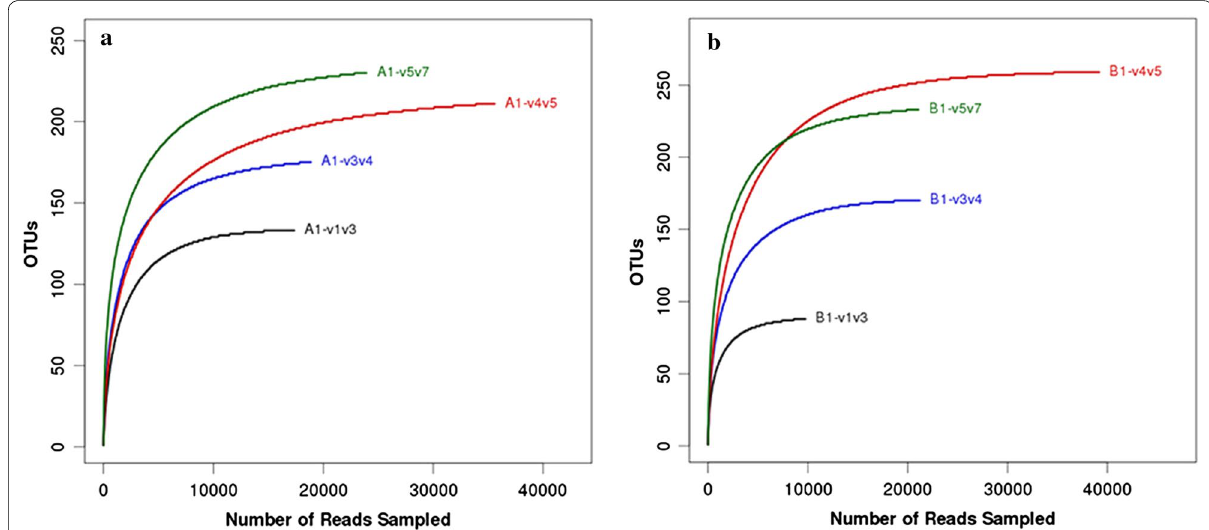
Fig. 1 Rarefaction analyses for the observed number of OTUs from the two samples (four regions) at a genetic distance of 3%. Rarefaction curves for each region are displayed in different colors, a sample A1 and b sample